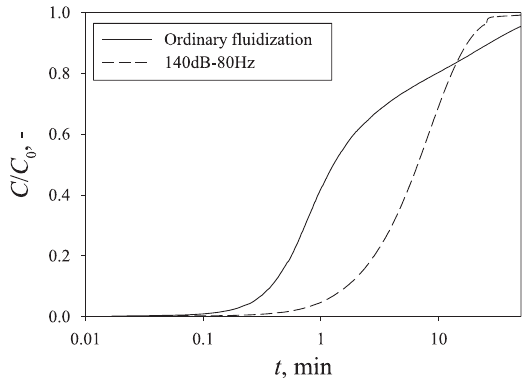
Fig. 15 Breakthrough curves obtained under ordinary and sound-assisted conditions in logarithmic